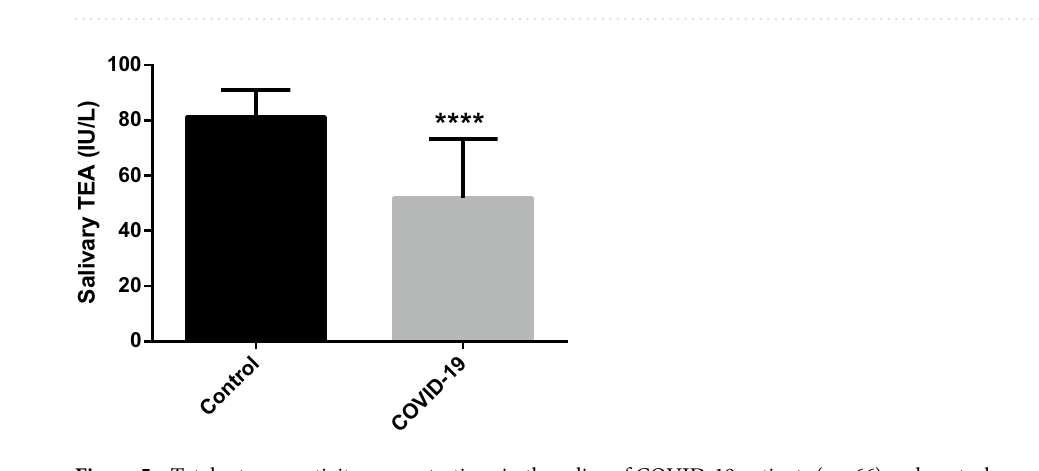
Figure 4. Interactome of GO terms differentially expressed in the saliva of COVID-19 patients, and their intermediate proteins. This analyse have been done with the Cytoscape application ClueGO and the REVIGO tool for GO terms selection. GO terms and proteins over-expressed in COVID-19 are in green, lower-expressed in COVID-19 are in red. GO terms in grey could not be attributed specifically to over or lower expressed terms/ proteins. GO terms in bold represent GO terms selected to be the most representative of their GO group defined by the REVIGO tool. Source: ClueGO (v2.5.8) app for Cytoscape (v3.9.0).